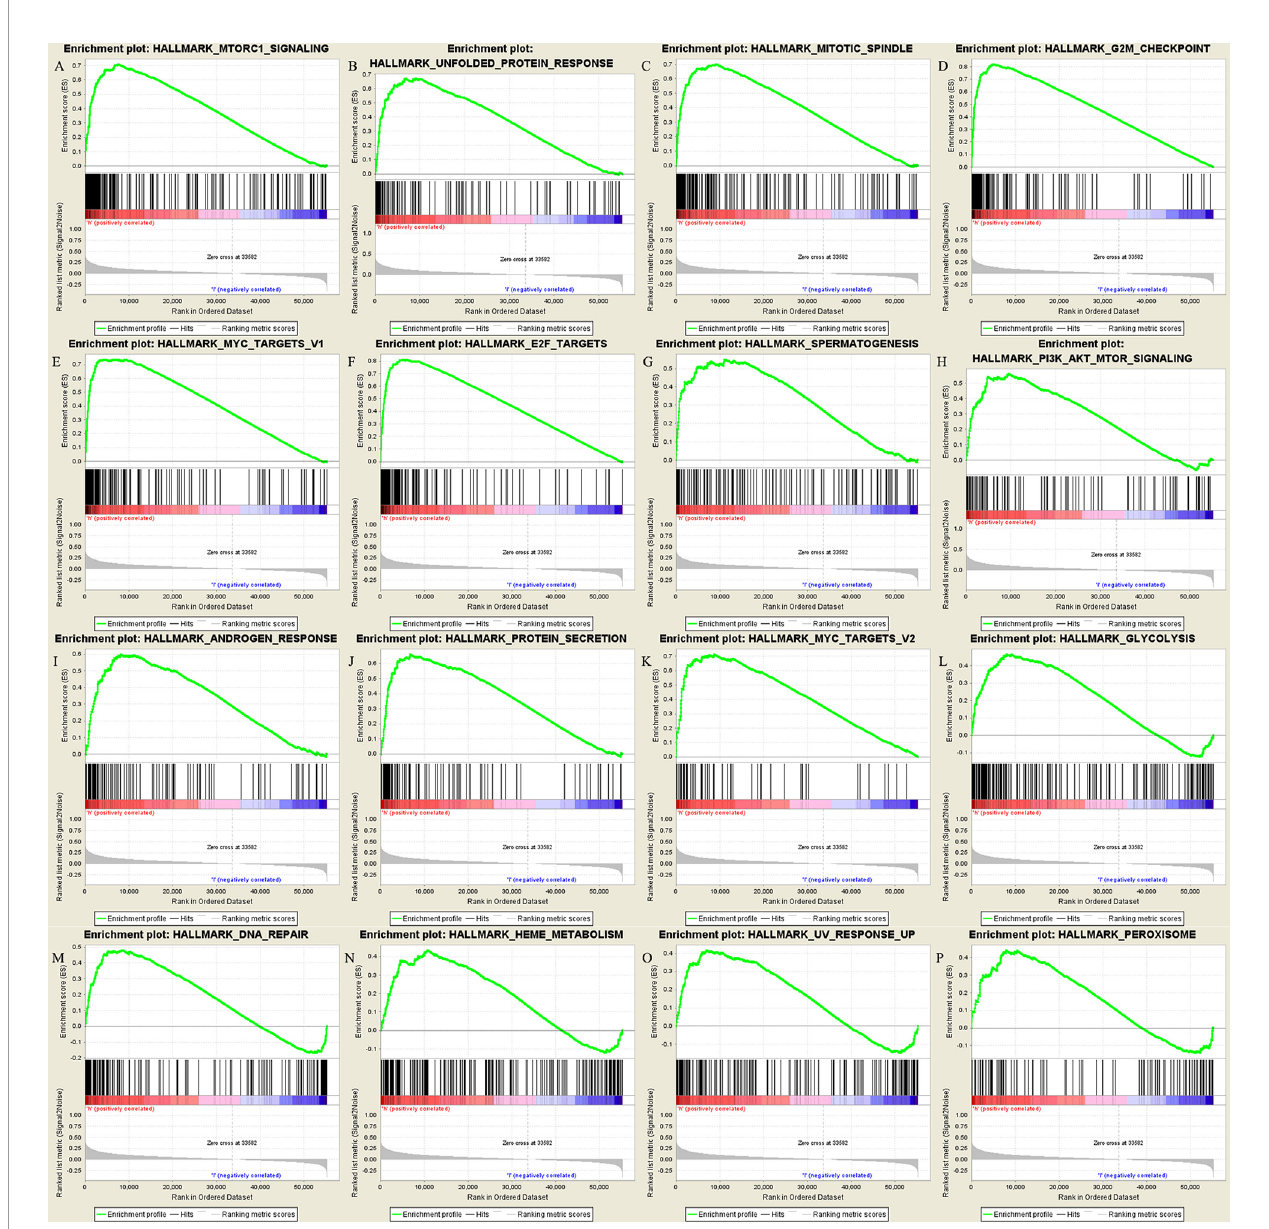
FIGURE 3 | Results of GSEA enrichment pathways: (A – P) in order of signi fi cance, they were the top 16 signi fi cantly enriched